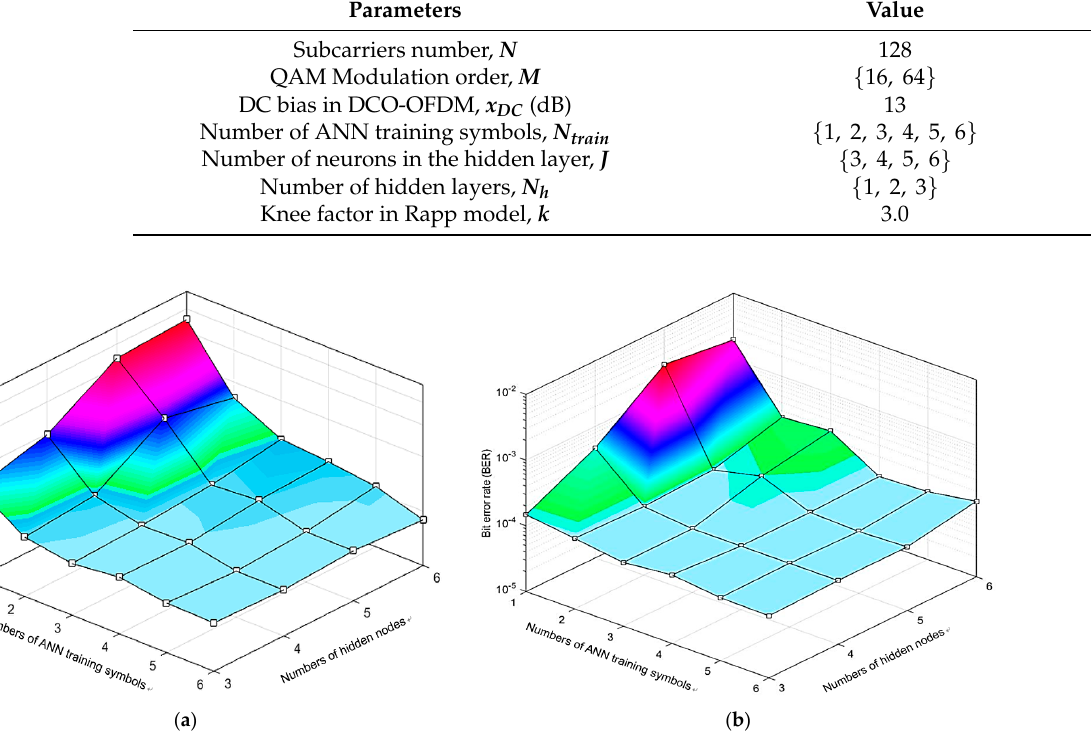
Figure 5. Illustration of the proposed ANN predistorter: ( a ) 16 QAM DCO-OFDM with E b / N 0 = 25 dB; ( b ) 64 QAM DCO-OFDM with E b / N 0 = 30